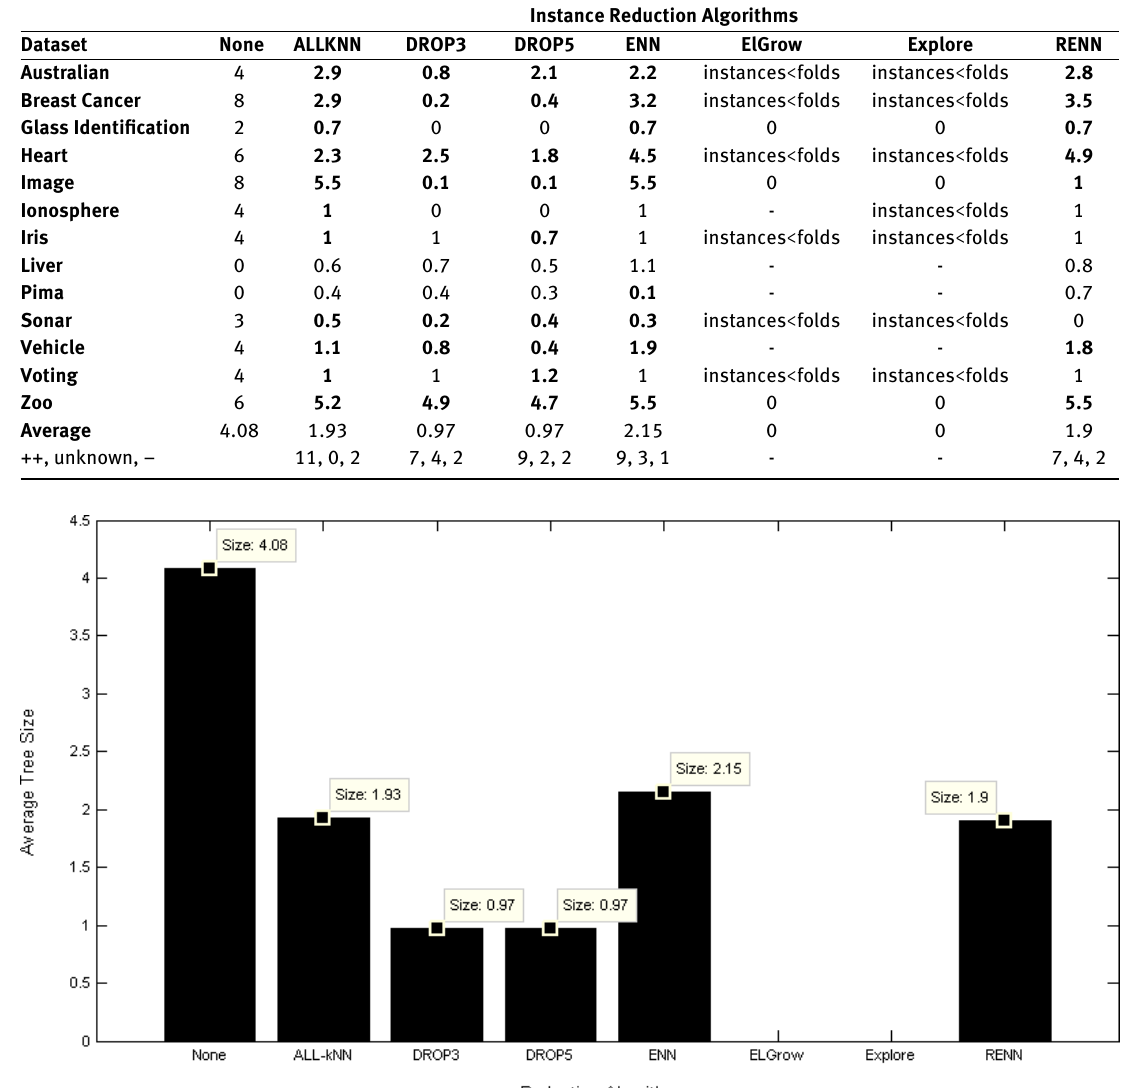
Table 7: Tree Size (Number of Nodes) for pruned trees With 0% noise ratio